Question: Condense the content of this figure into a single sentence.
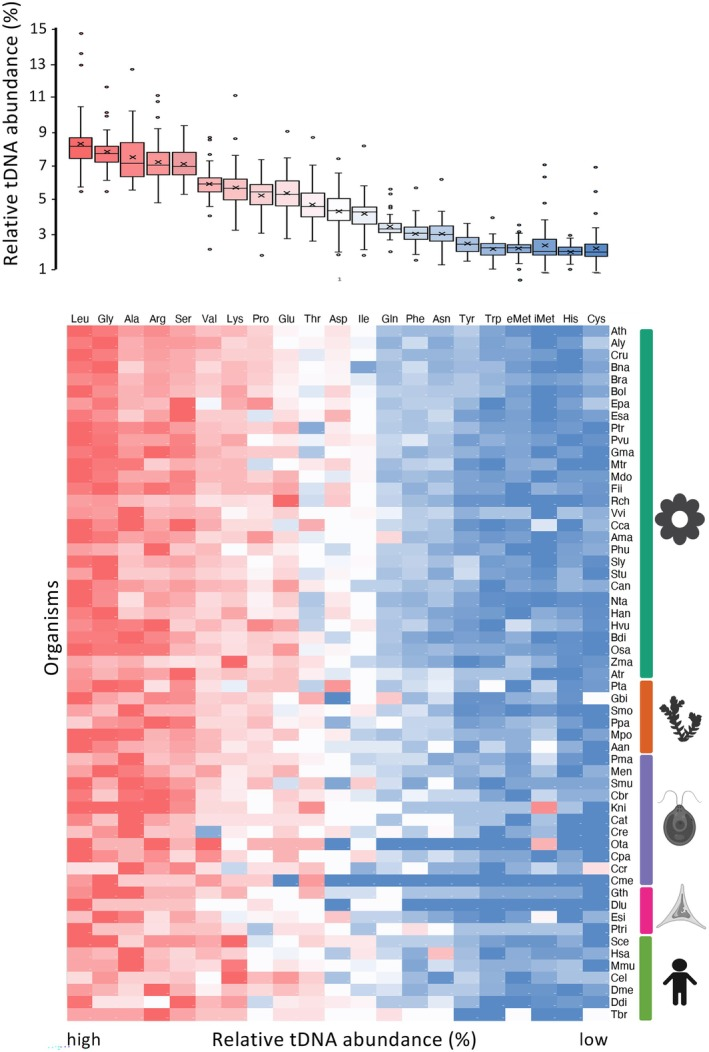
Answer: Conserved distribution of tDNA copy‐numbers across eukaryotes. Box plot (top) and heat map (bottom) showing the distribution of nuclear tDNA copy numbers per amino acid across representative photosynthetic organisms and other eukaryotes. Amino acids are ordered according to amino acid frequency in Arabidopsis thaliana (Michaud et al., 2011 ). Elongator methionine (eMet) and initiator methionine (iMet) tRNAs are distinguished. Clustered tDNAs were excluded. Names of photosynthetic organisms are abbreviated as in Table S1 .